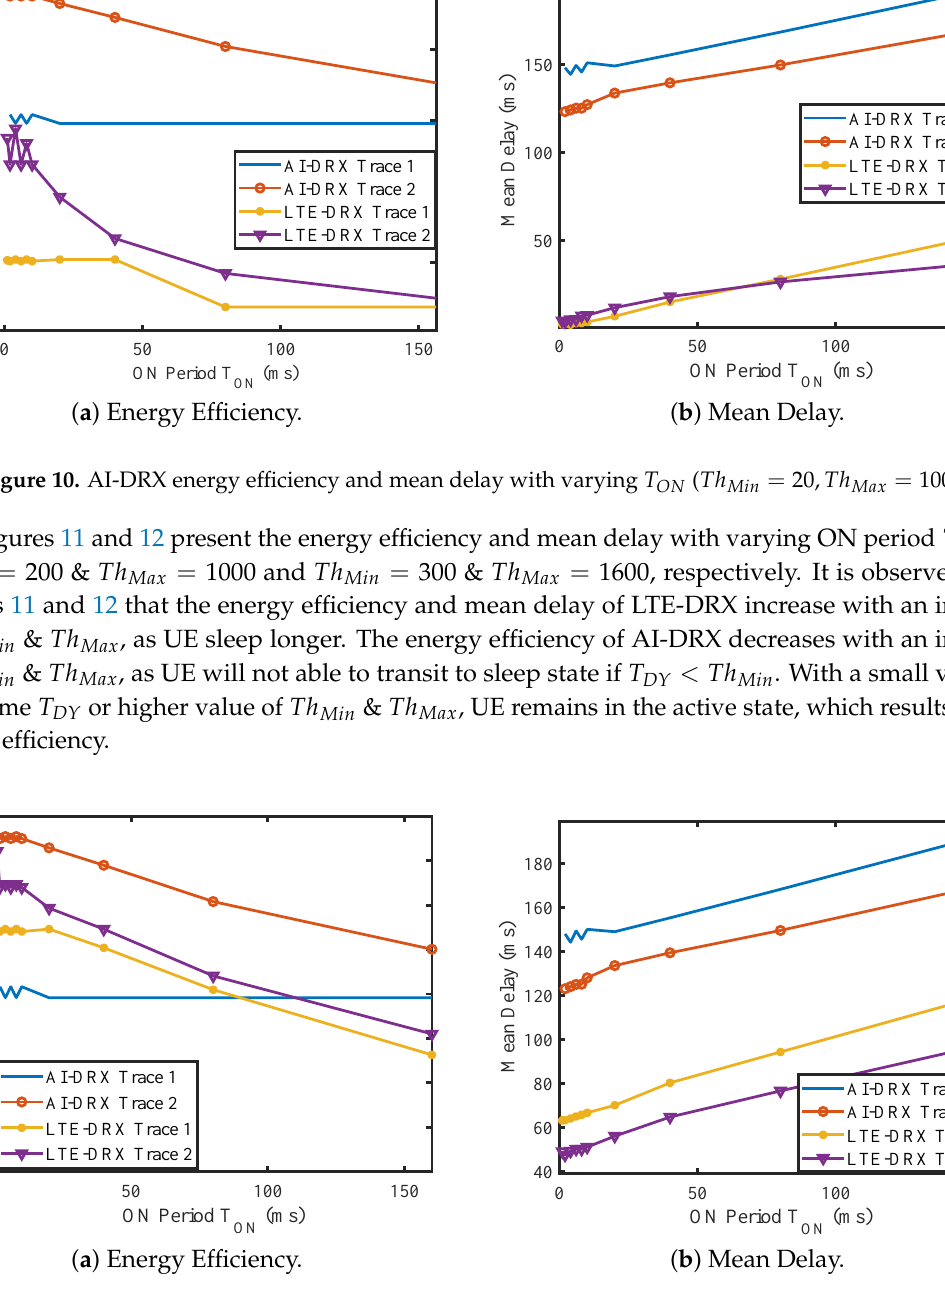
Figure 11. AI-DRX energy efficiency and mean delay with varying T ON ( Th Min = 200, Th Max =